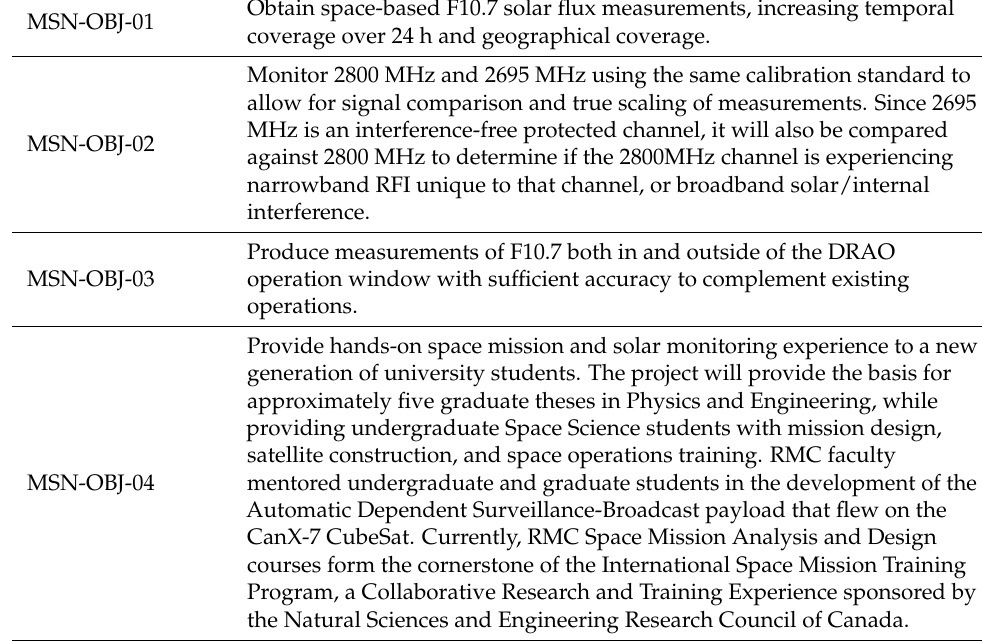
Table 1. Primary mission objectives of RMCSat.